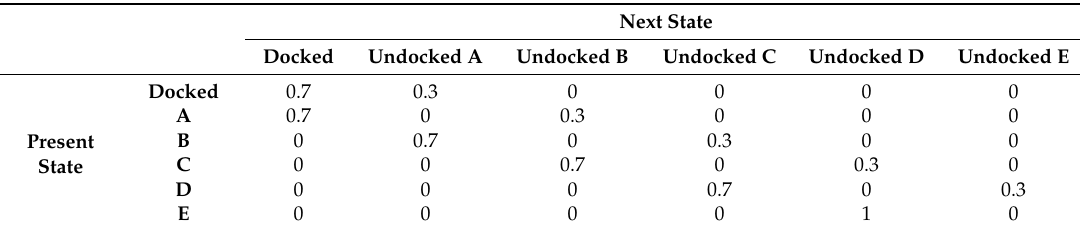
Figure 3. A state transition model that emulates the movement of a subject with the states defining the position from the receiving base station. Table 6. State transition table of the emulated walk that follows the Markov process—Activity level: Moderate.